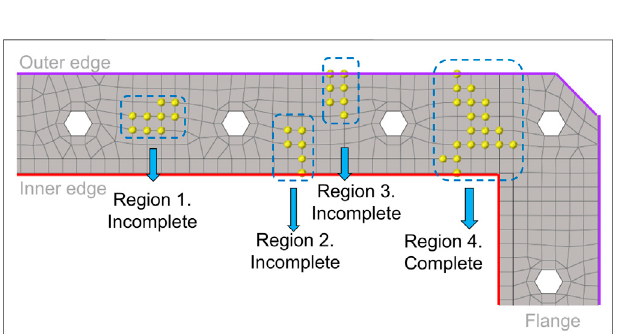
FIGURE 6 | Illustration of the leak channel.